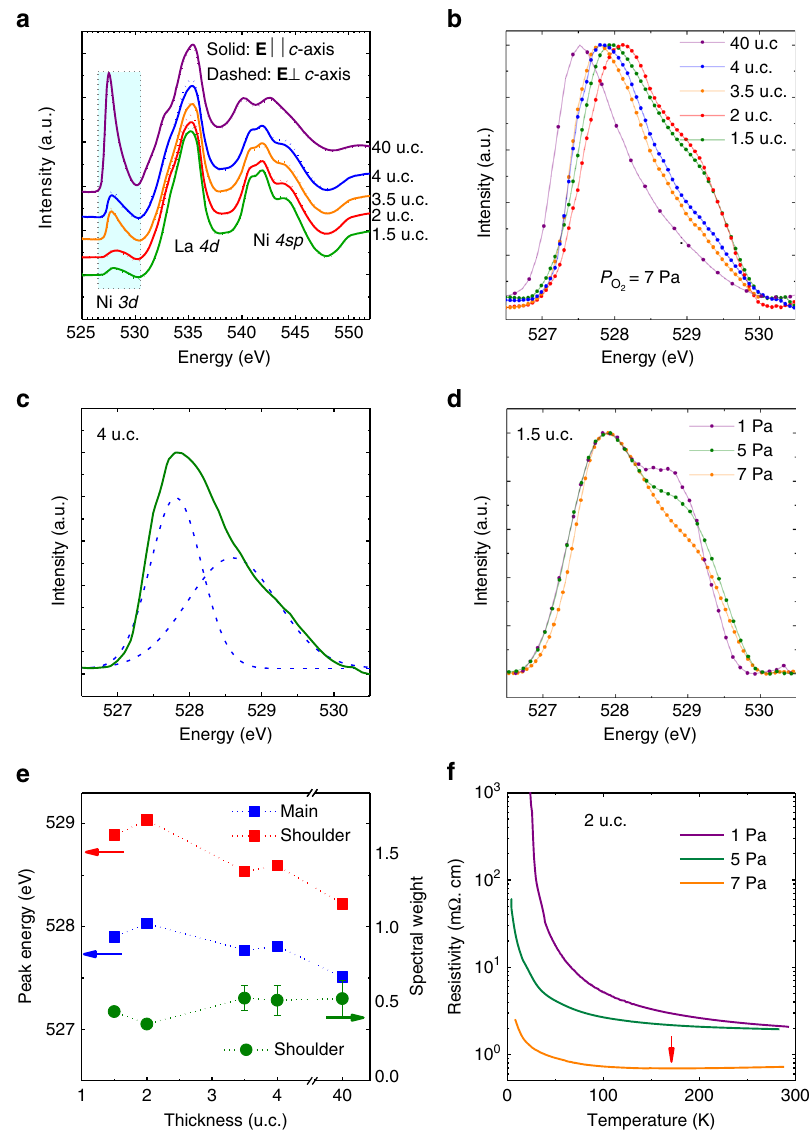
Fig. 3 X-ray absorption spectroscopy at the oxygen K edge. a X-ray absorption spectra at O- K edge for polarizations parallel (solid line) and perpendicular (dashed line) to the c -axis of the LaNiO 3 fi lms. b Normalized polarization-averaged XAS spectra of the oxygen pre-edge region for fi lms with various thicknesses. c Fitting of the pre-edge peak for the 4 u.c. fi lm (green line) using two Gaussian functions (dashed blue line). d Normalized pre-edge peak for 1.5 u.c. fi lms grown at 1, 5, and 7 Pa oxygen pressures, respectively. e Spectral weight of the shoulder peak, A shoulder / A total , where A is the area under the peak, and the energies of the main and shoulder peaks vs. thickness of the LaNiO 3 fi lm grown under 7 Pa oxygen pressure. The error bars for the spectral weight are the standard errors of the mean from the Gaussian fi tting of the pre-edge peak areas. f Temperature-dependent resistivity curves for 2 u.c. LaNiO 3 fi lms grown under oxygen pressures of 1, 5, and 7 Pa, respectively. Red arrow points to the metal to insulator transition temperature for the fi lm grown at 7